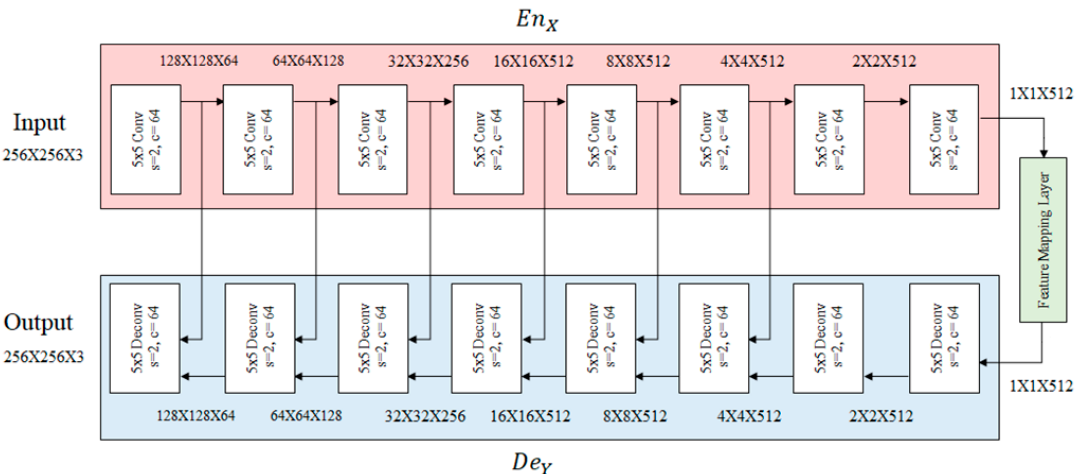
Figure 4. The generator architecture of our model based on Pix2pix. Cross-connected structure of the pre-trained encoder and decoder with feature mapping layer and skip-connection of U-net.